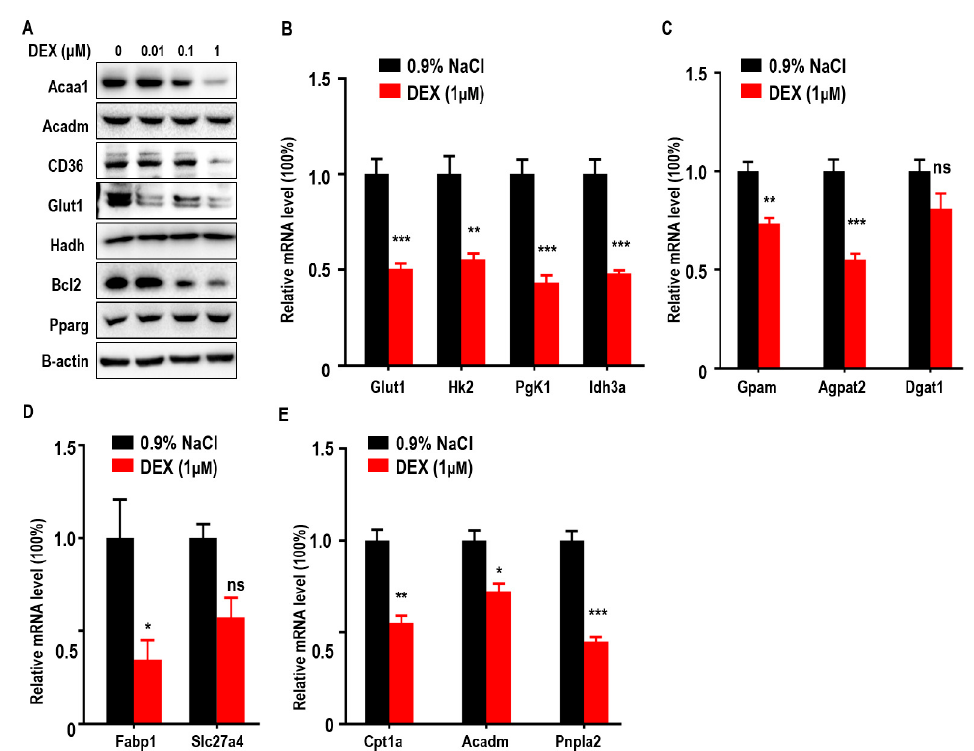
Figure 4. Treatment with DEX inhibits metabolism enzyme levels relevant to glycolysis, TG synthesis, FFA import, and FAO, and upregulates Pparg levels in vitro. ( A ) Immunoblot analysis of Acaa1, Acadm, CD36, Glut1, hydroxyacyl-CoA dehydrogenase (Hadh), Pparg, and Bcl2 in LLC cells treated with 0.9% NaCl or various doses of DEX (0.01, 0.1, 1 µ M), respectively. ( B – E ) Quantitative RT-PCR analysis of genes relevant to glycolysis pathway enzymes ( B ), TG synthesis ( C ), FFA import ( D ), and the FAO pathway ( E ), in LLC cells after treatment with 0.9% NaCl or 1 µ M DEX, respectively. All data are presented as mean ± SEM and p < 0.05 is considered significant (* p < 0.05, ** p < 0.01, *** p <